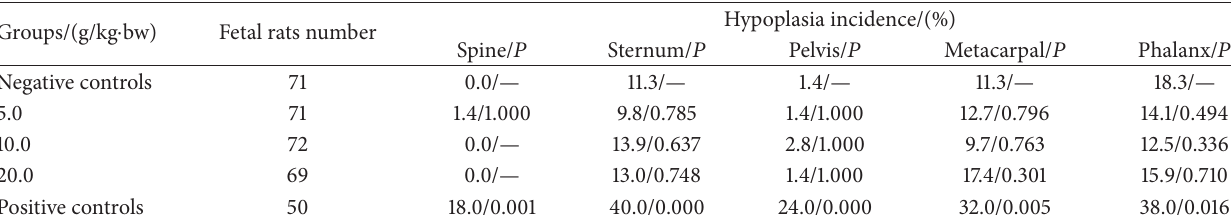
Table 8: Effect of C. paliurus leaf aqueous extract on skeletal development of fetal